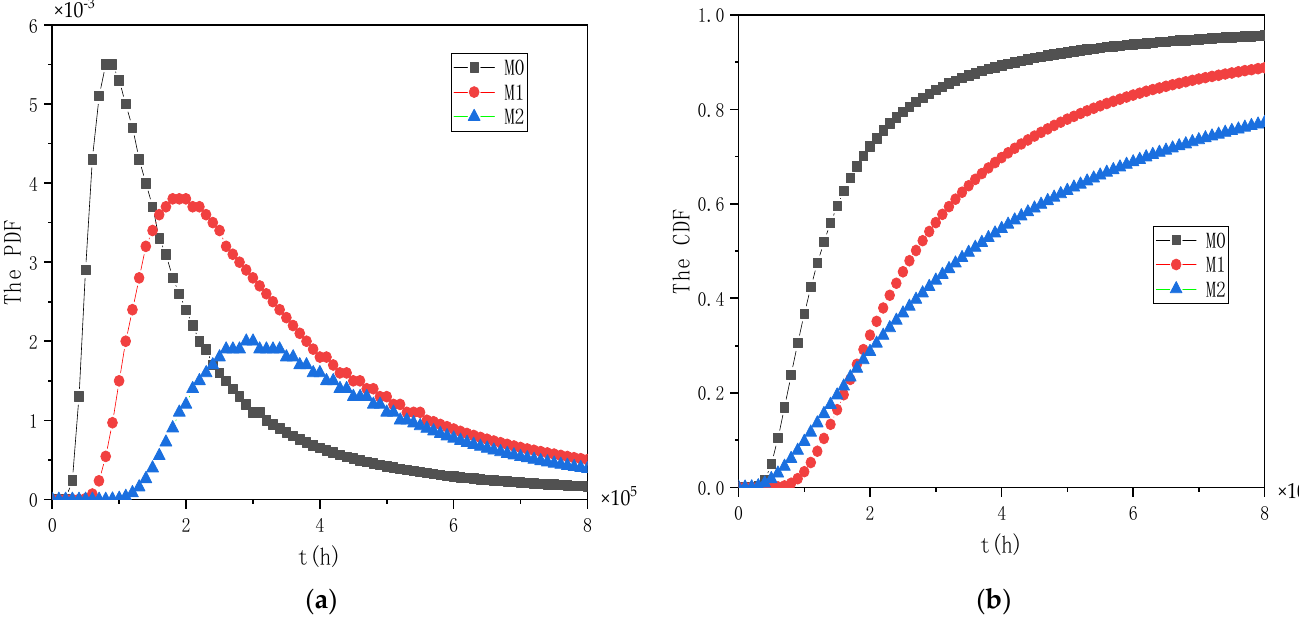
Figure 3. The comparison of the PDF and CDF of the three models for TWT CSADT data ( a ) PDF, ( b ) CDF.